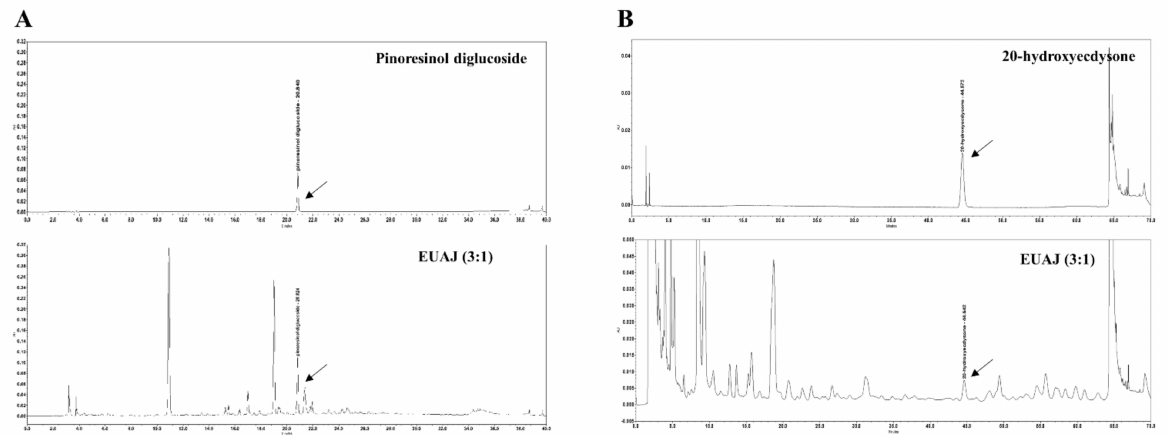
Figure 2. HPLC analysis of EUAJ (3:1). The contents of two ingredients in EUAJ (3:1) are shown using ( A ) pinoresinol diglucoside (PDG) and ( B ) 20-hydroxyecdysone (20HE) as standards.